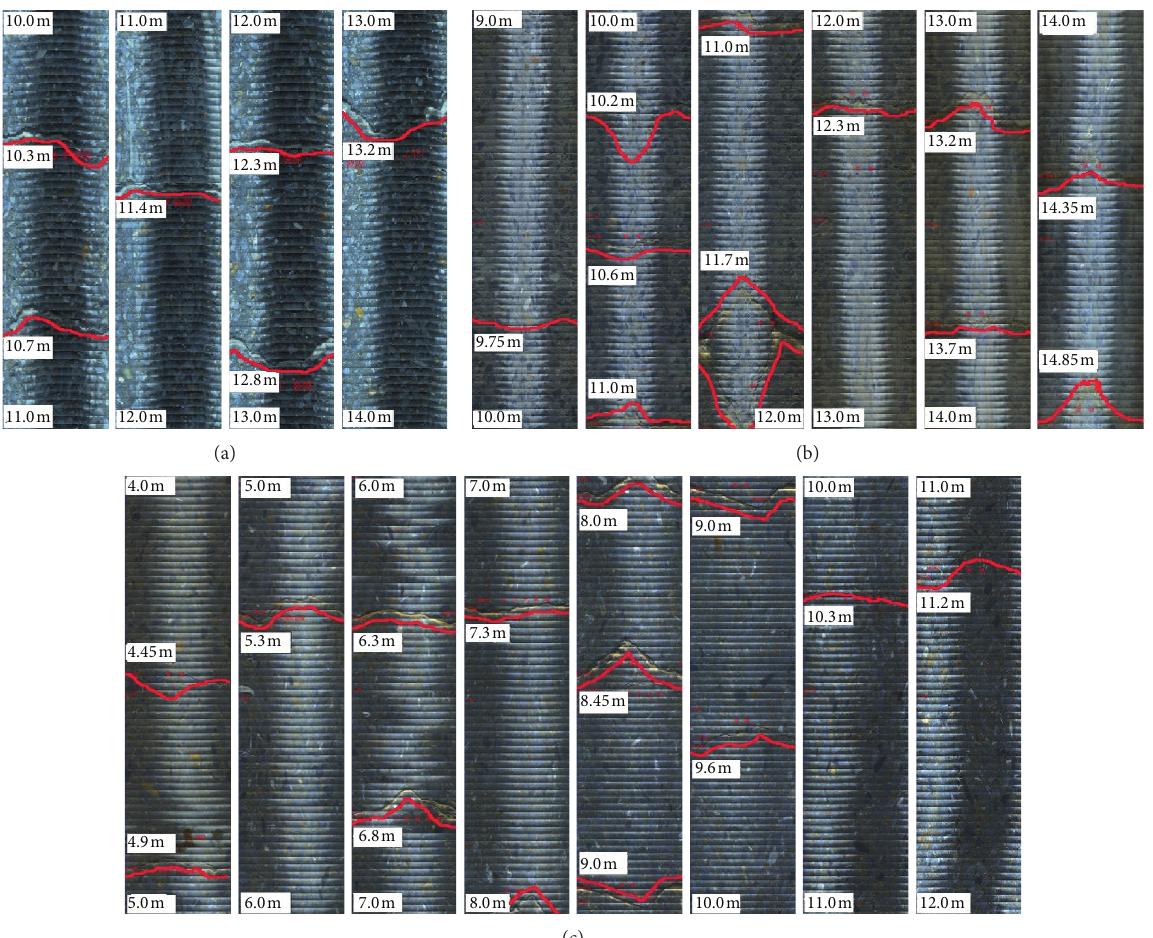
Figure 9: Results of borehole images: (a) fractures of pile 2 of pier #3; (b) fractures of pile 4 of pier #3; (c) fractures of pile 1 of pier